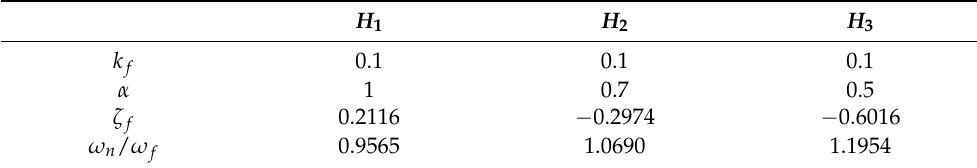
Table 1. Tuning parameters of implemented fractional-order